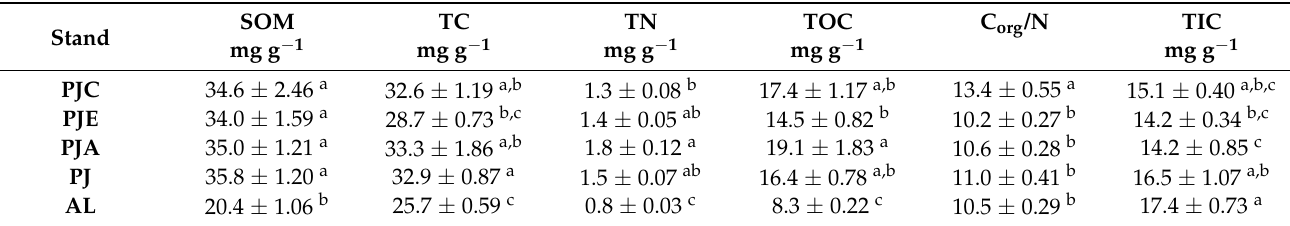
(Table 2). Among the stands, PJE had the smallest TC and TOC values, and PJA the highest TC, TN, and TOC. Soils supporting the N-fixing species (PJA and PJE) were the poorest in TIC, while the arable soil (AL) was the richest. Table 2. Soil chemical properties of the investigated tree stands and the arable land (see Table 1 for site labels). Values are mean and standard error ( n = 15). Superscript letters indicate significant differences within means in the column according to one-way ANOVA at p ≤ 0.05 and Tukey’s